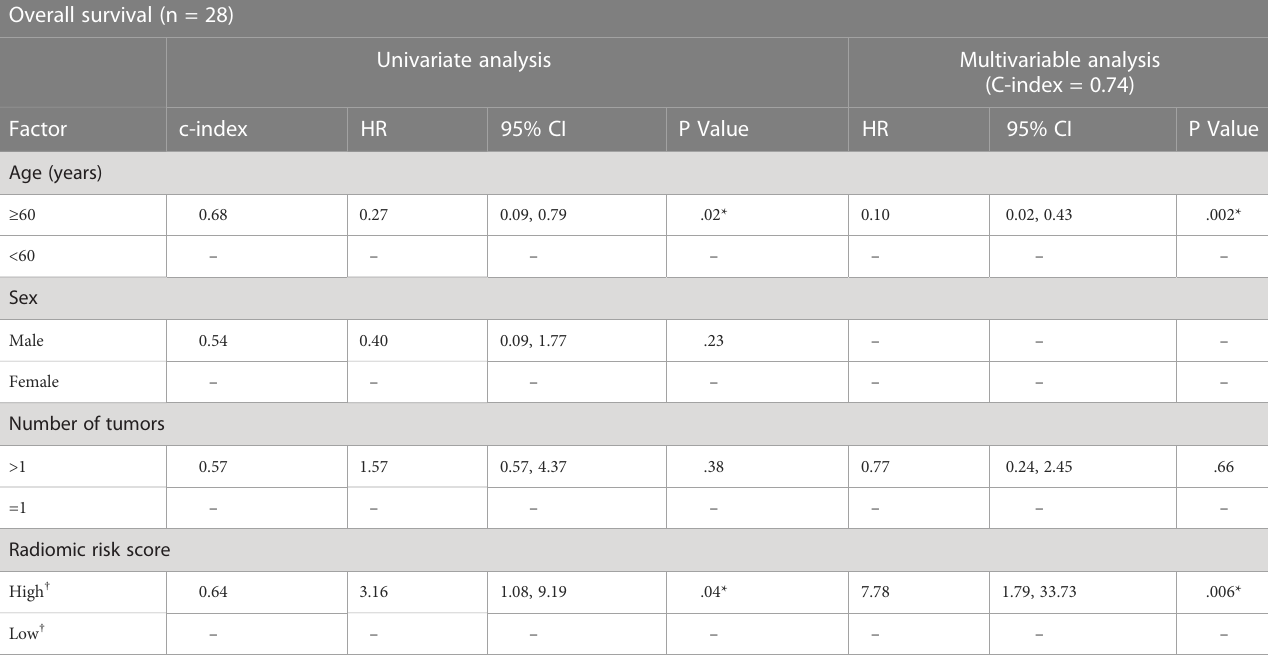
TABLE 4 Cox regression model results for the association of radiomics biomarker with overall survival in the Gd-DTPA cohort. Overall survival (n = 28) Univariate analysis